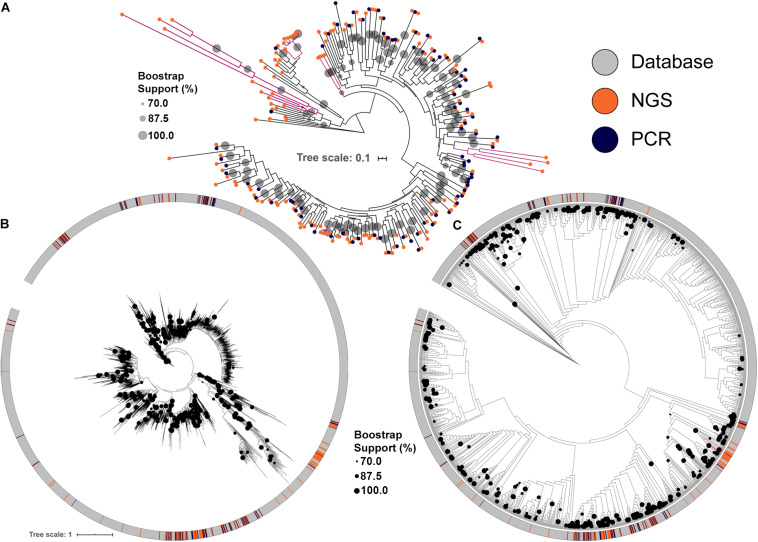
Maximum likelihood tree of KS domains recovered from the soil metagenomic library. Clades in magenta are formed uniquely by domains recovered by NGS. (A) KS domains recovered either by PCR or by NGS. (B) KS domains recovered from the soil metagenomic library and from the MIBiG database showing branch lengths. (C) KS domains recovered from the soil metagenomic library and from the MIBiG database showing topology only to facilitate visualization. Circles in the tree represent branch bootstrap support >70%.